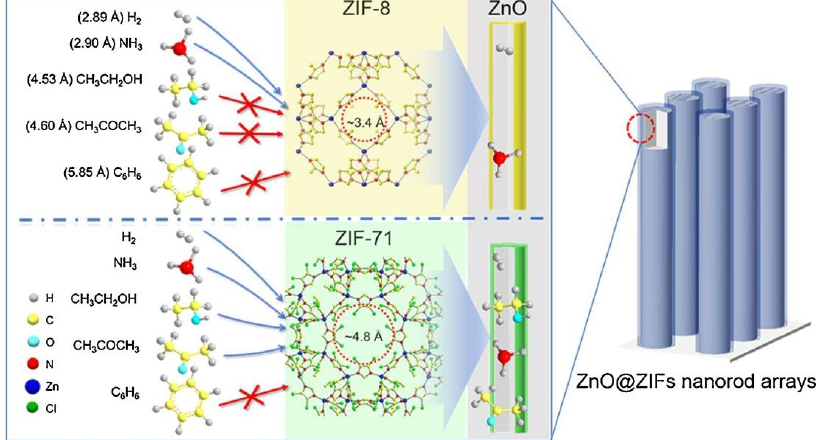
Figure 7. Sieving effect of ZIF-8 and ZIF-71 in ZnO@ZIF NRAs. Reprinted with permission from Ref. [204], copyright 2018 Elsevier.